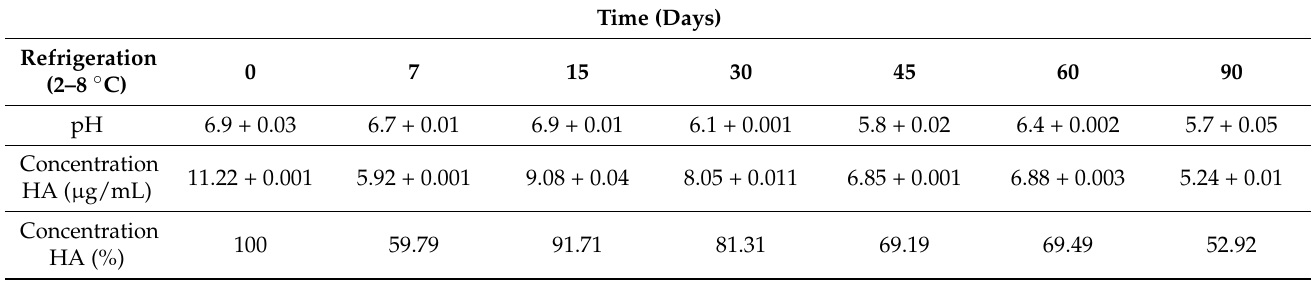
Table 2. Physicochemical characteristics of OG + HA stored at refrigeration temperature for 90 days.